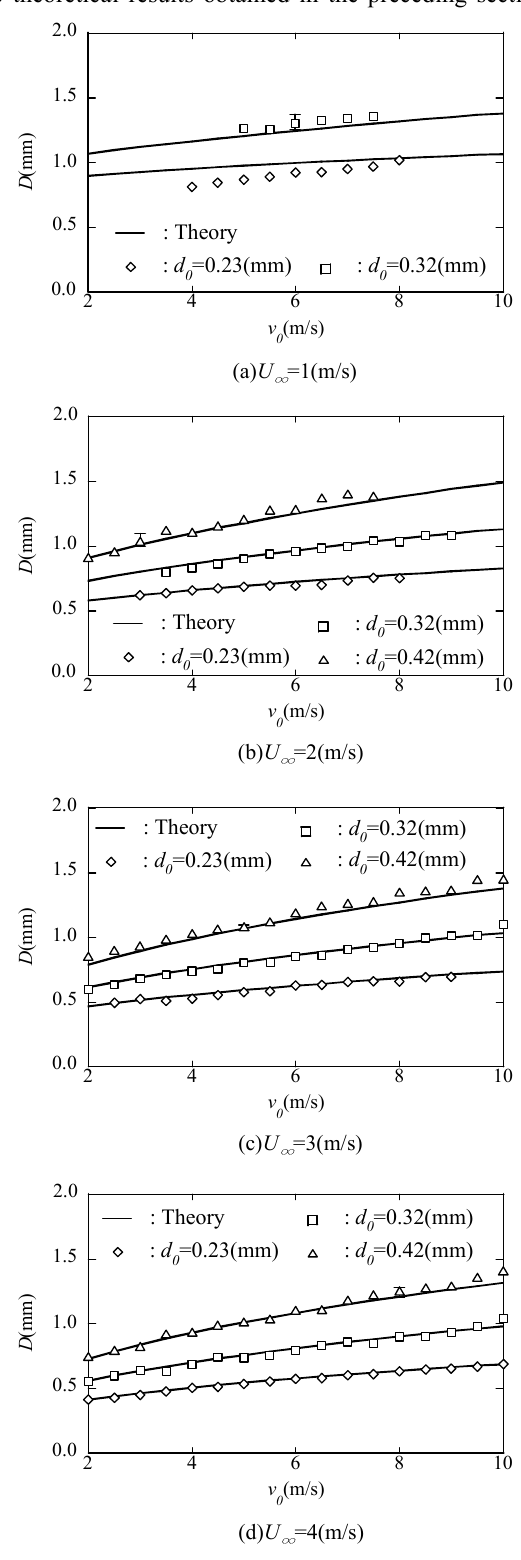
Fig.10 Theoretical and experimental separated bubble